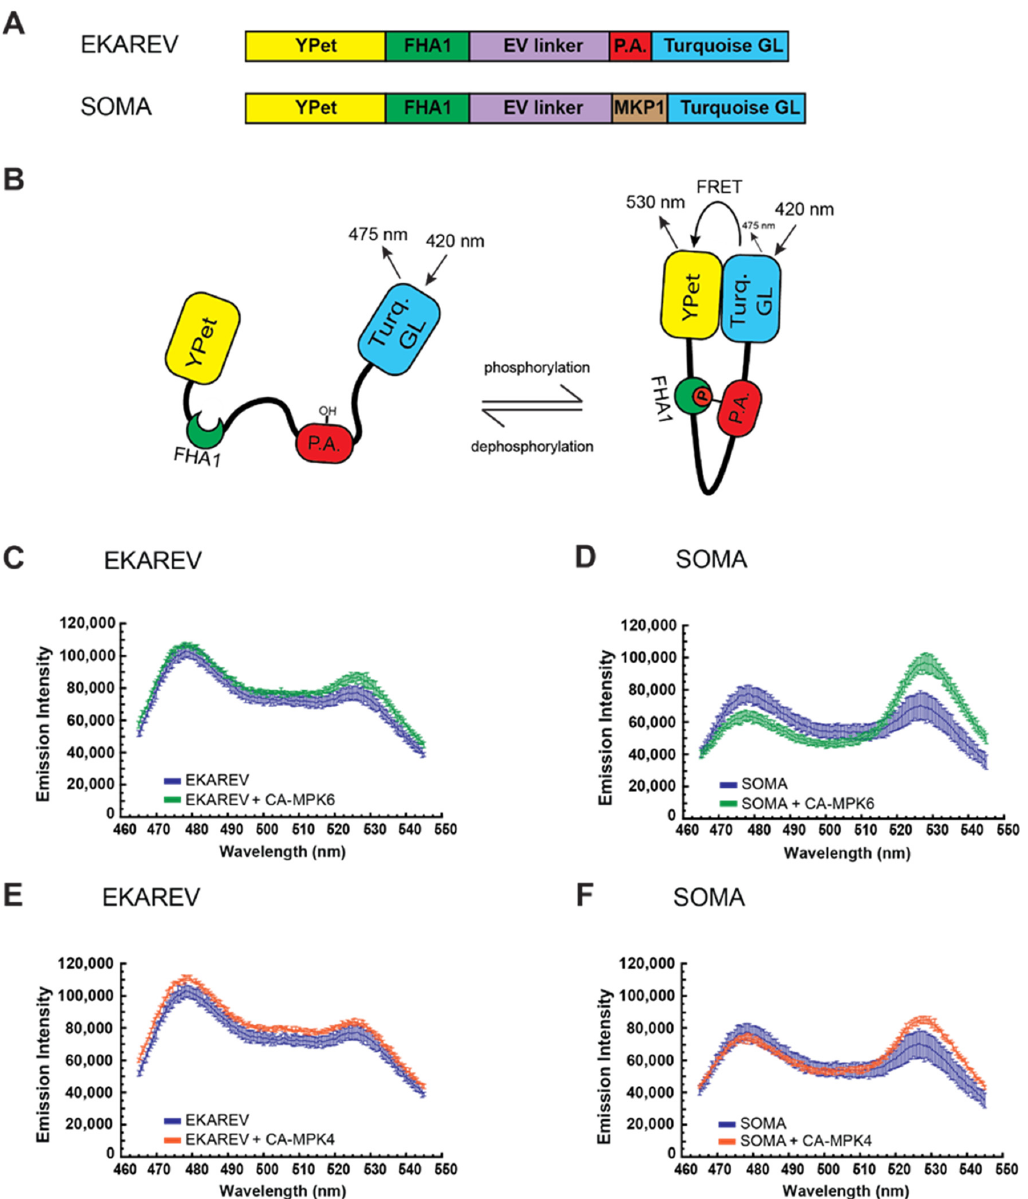
Figure 1. Development of the plant mitogen-activated protein kinase (MAPK) docking domain trap. ( A ) Domain structure of EKAREV and sensor of MAPK in Arabidopsis (SOMA). YPet is a yellow fluorescent protein, FHA is the FHA1 phosphopeptide binding domain of yeast RAD53, EV linker is a flexible linker domain, P.A. is the phosphoacceptor region of the mammalian CdC25C protein, MKP1 is an 80 amino acid region of the Arabidopsis MKP1 protein, and Turquoise GL is a blue fluorescent protein. Maps are not to scale. ( B ) Cartoon schematic of the EKAREV biosensor. Phosphorylation of EKAREV within the phosphoacceptor domain is expected to produce a conformation shift that increases Förster resonance energy transfer (FRET) efficiency between the Turquoise GL and YPet fluorophores due to the enhanced affinity of the FHA1 domain for the phosphorylated form of the phosphoacceptor domain. Removal of the phosphate is expected to cause EKAREV to revert to a conformation with lower FRET efficiency. ( C – F ) Data from in vitro FRET assays using EKAREV ( C , E ) or SOMA ( D , F ) in the presence or absence of constitutively active MPK6 (CA-MPK6) ( C , D ) or MPK4 (CA-MPK4) ( E , F ). The emission spectra of the biosensors in response to excitation with 420 nm light is shown. Three technical replications were performed for each experiment, and the values plotted are the means for those three trials with the error bars indicating standard deviation. Absence of a CA-MAPK is represented in blue. Presence of CA-MPK6 is represented in green. Presence of CA-MPK4 is represented in orange. Emission intensity units are arbitrary “counts per